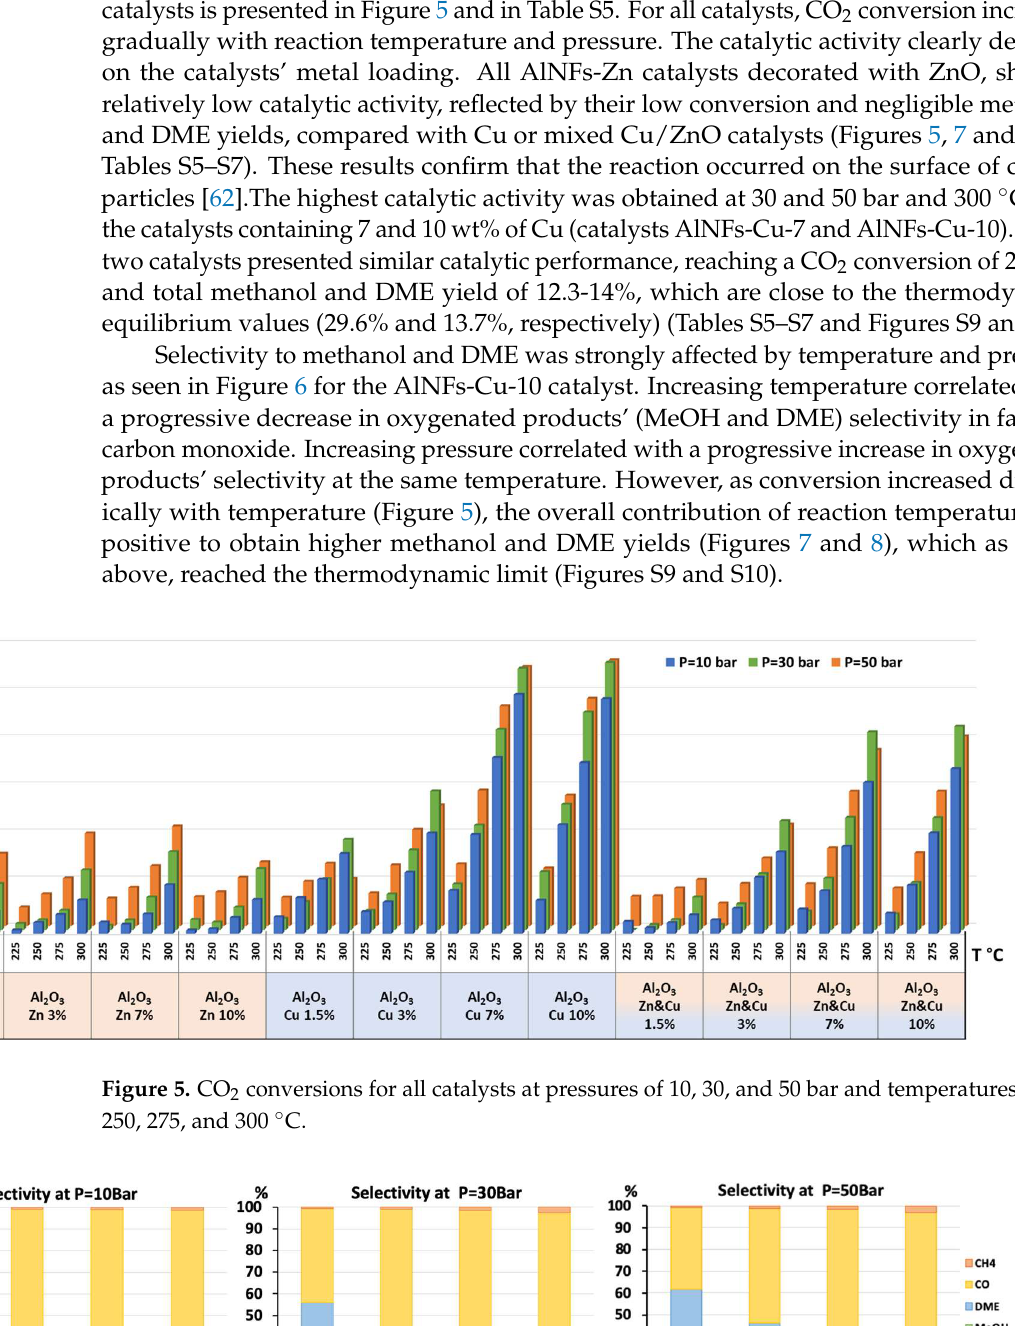
Figure 7. Methanol yield for all catalysts at pressures of 10, 30, and 50 bar and temperatures of 225, 250, 275, and 300 °C.